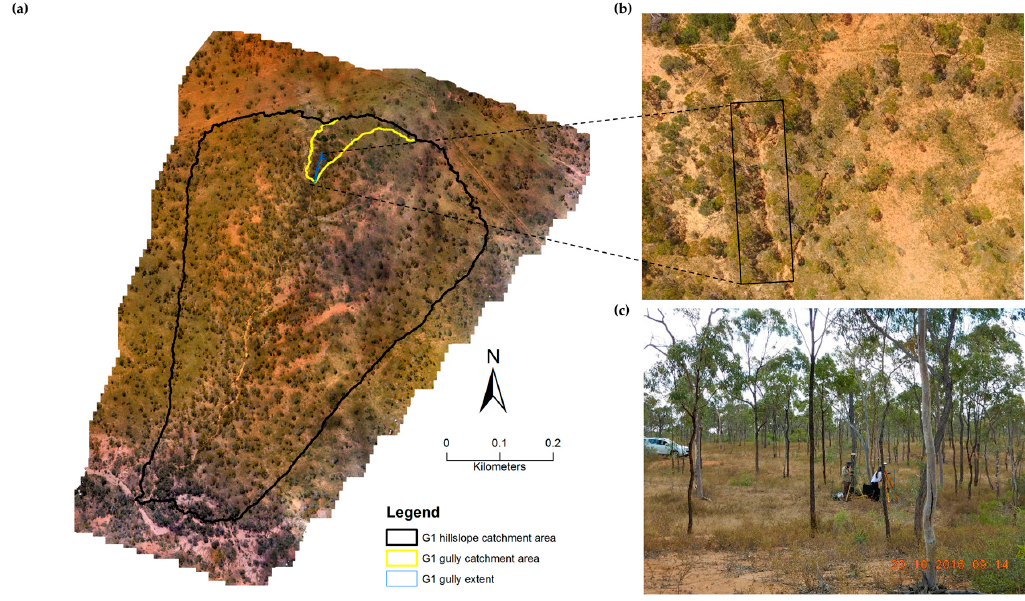
Figure 2. ( a ) Map showing the catchment area of G1 and the individual gully site. Background map is a UAV ortho-photo mosaic of G1. ( b ) UAV image of the gully site. ( c ) Ground image of typical savanna vegetation in the contributing area of G1.